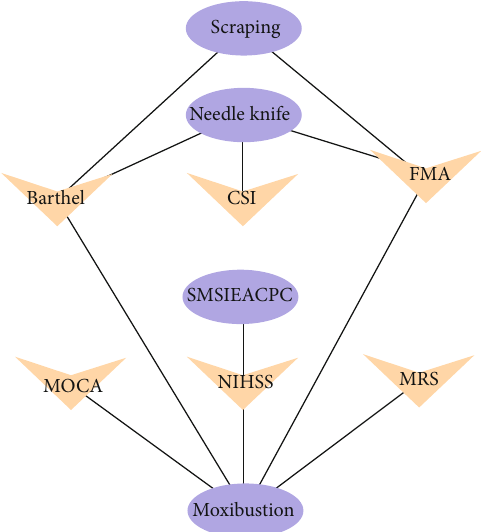
Figure 12: Analysis diagram of OTTCM-index network